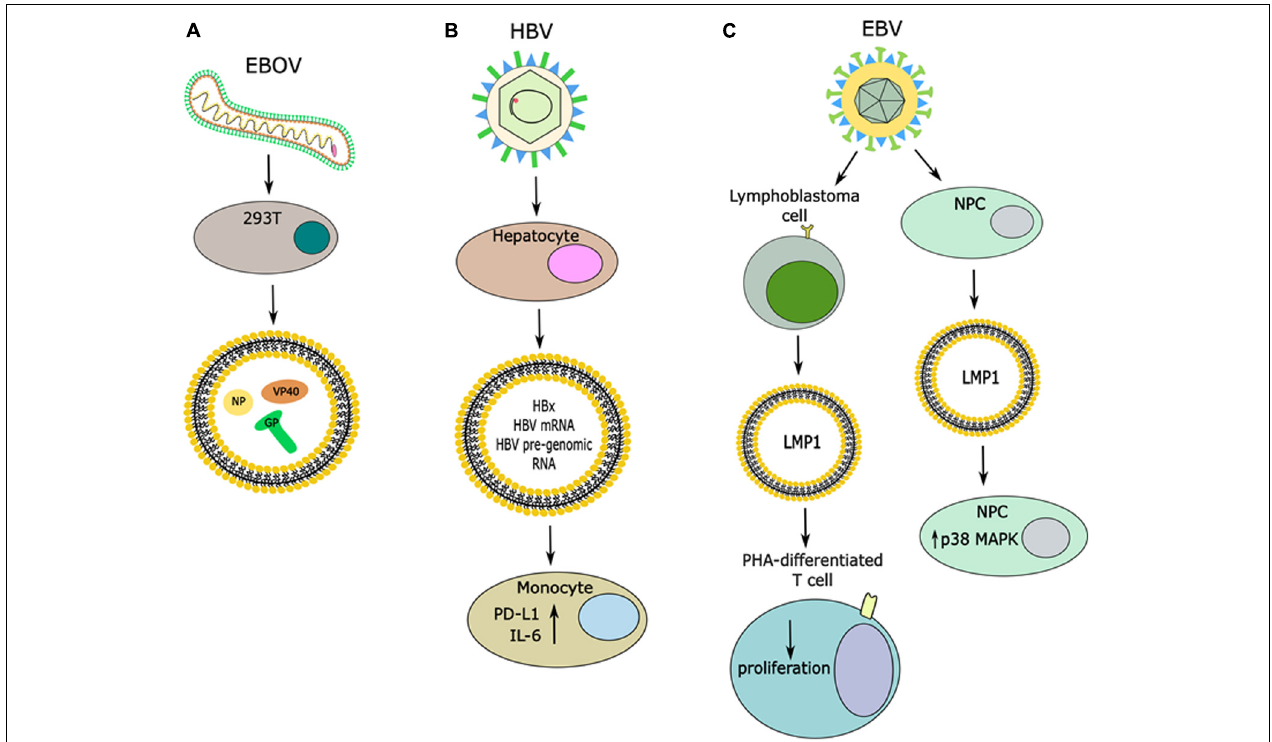
FIGURE 3 | Release of viral proteins in EVs and effects in recipient cells. (A) Infection with EBOV causes the release of vesicles that contain viral proteins, including the NP, GP, and VP40. (B) Infection of hepatocytes with HBV induces the release of vesicles that contain the HBx protein, it’s mRNA and HBV pre-genomic RNA. Uptake of these vesicles by monocytes can cause increases in expression of PD-L1 and IL-6. (C) Infection of multiple different cell types with EBV has been shown to induce the release of LMP1 in EVs. When these EVs are taken up by PHA-differentiated T cells it caused decreased proliferation, while uptake of LMP1 + EVs by NPCs caused an increase in p38 MAP kinase